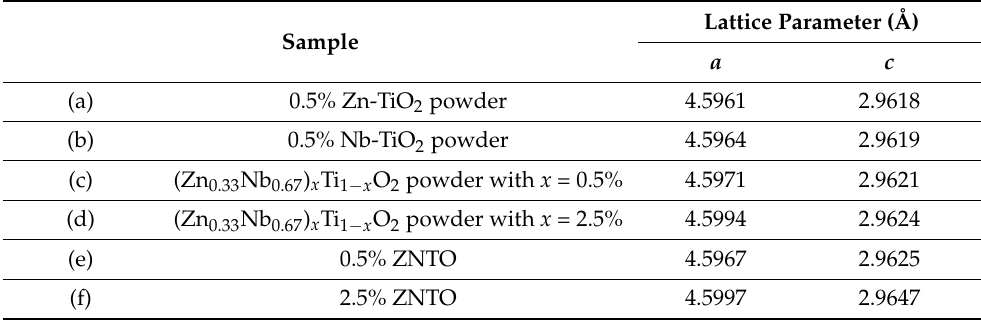
Figure 1. XRD patterns of single doped (a) Zn, (b) Nb in TiO 2 powder and (Zn 0.33 Nb 0.67 ) x Ti 1 − x O 2 powder with x = (c) 0.5%, (d) 2.5% and (e) 0.5% ZNTO, (f) 2.5% ZNTO ceramics. Table 1. Lattice parameter of ZNTO powders and ceramics with difference codoping